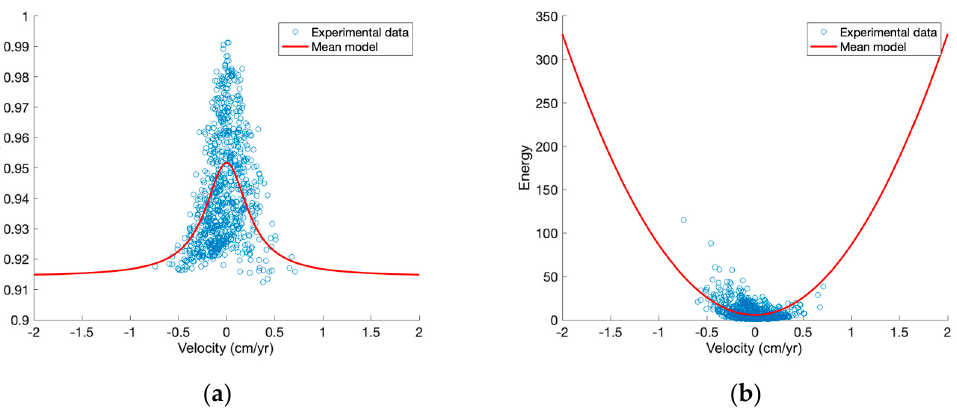
Figure 11. Correlation between LOS velocity and entropy–energy dispersion in the period from 2011 to 2015 for a building complex near San Giovanni station: ( a ) Entropy–velocity dispersion; ( b ) Energy–velocity dispersion.